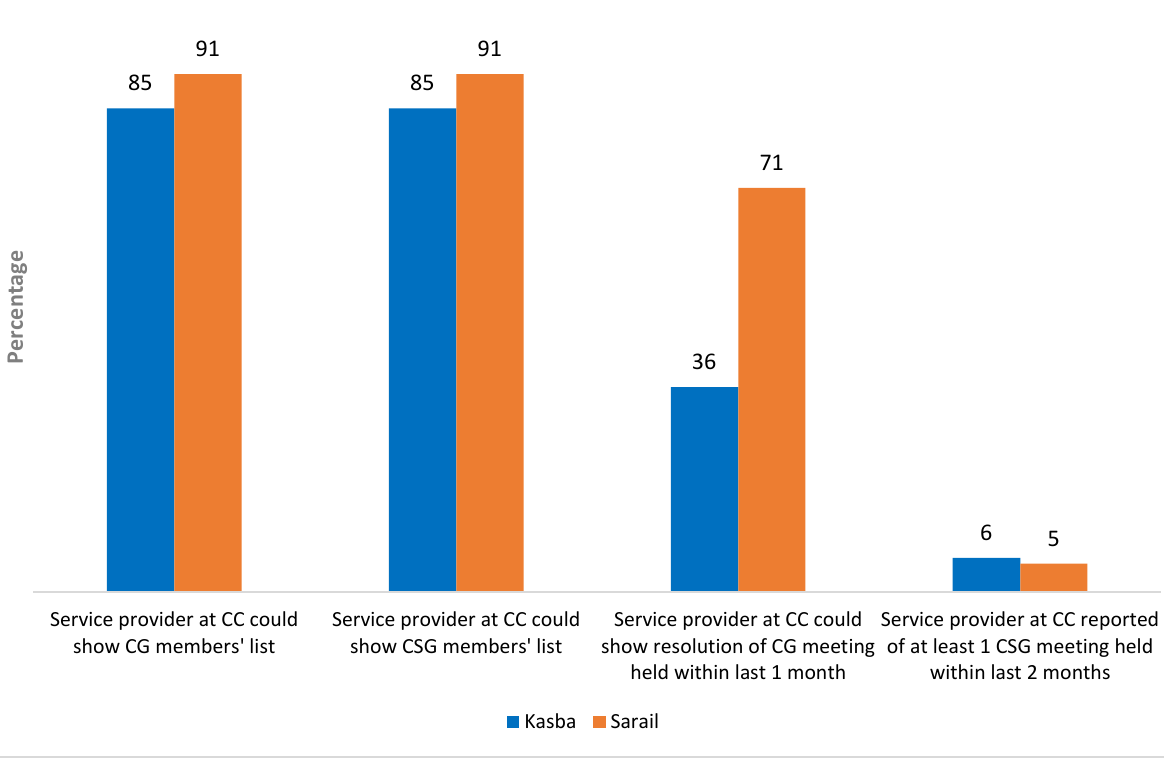
Figure 4. Functionality of CGs and CSGs at Kasba (n = 33) and Sarail (n = 21).